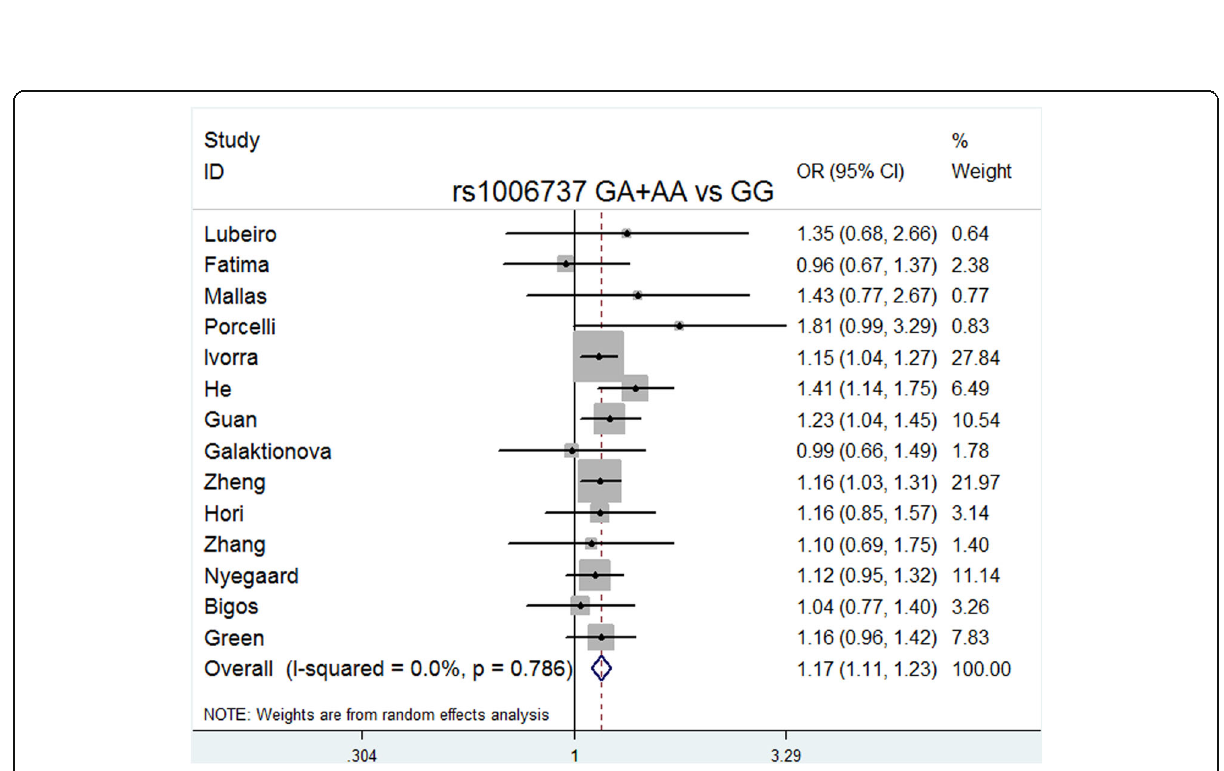
Fig. 3 Forest plot of the dominant model (GA + AA vs. GG) for rs1006737. Significant differences between rs1006737 and the risk of schizophrenia were observed with the dominant model (GA + AA vs. GG) (OR = 1.169, 95% CI = 1.107 – 1.234, P heterogeneity = 0.786, P =